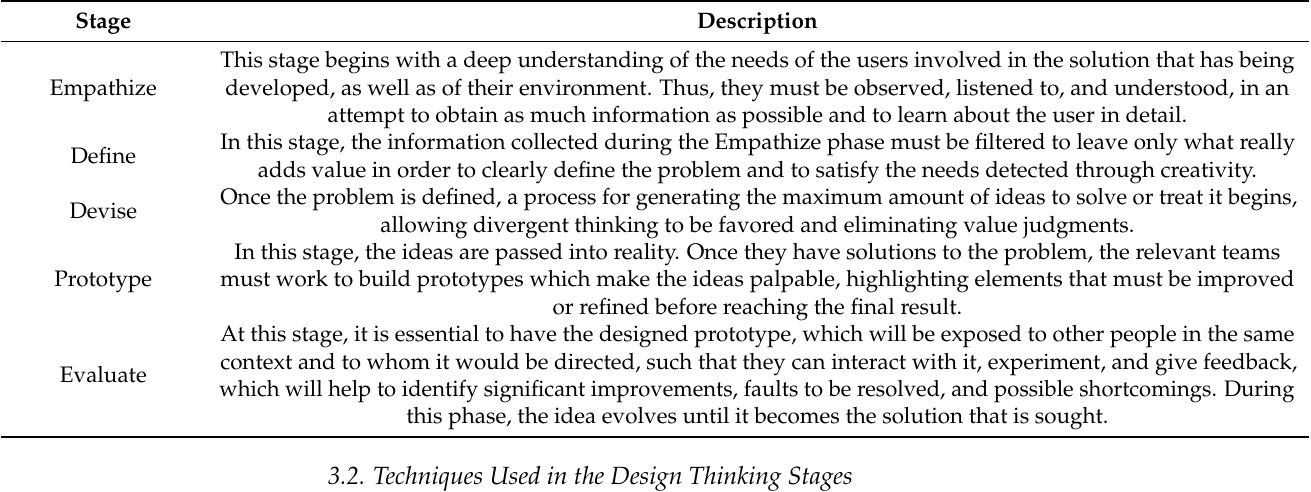
Table 1. Description of the stages of the design thinking methodology [27,29,30].